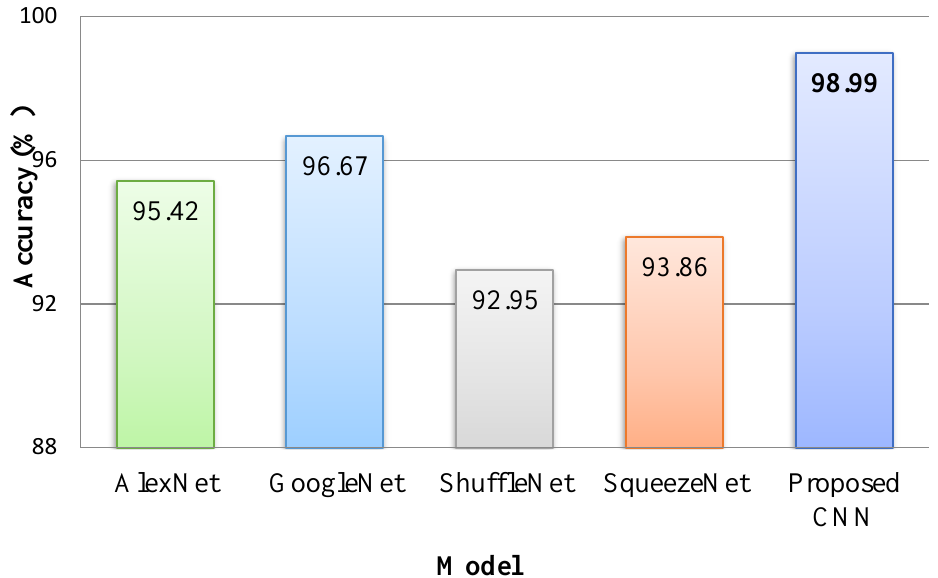
Figure 11. Classification accuracy rates obtained with CNN models.